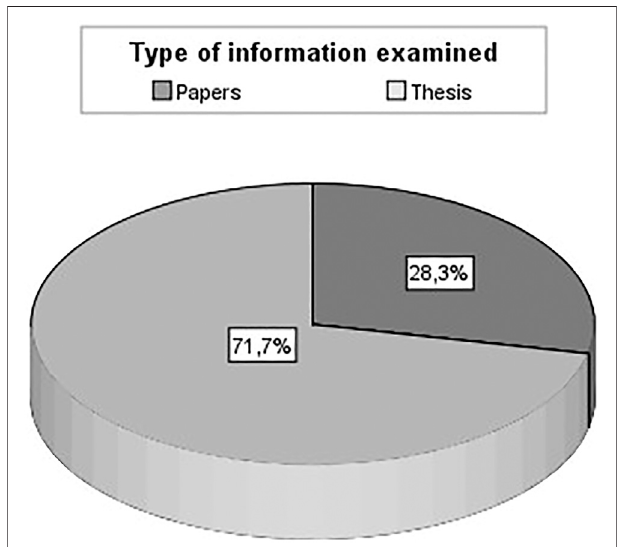
FIGURE 3 | Frequency of types of information addressing aquatic macroinvertebrate studies in arid and semi-arid ecosystems of Peru between years 1992 – 2020.